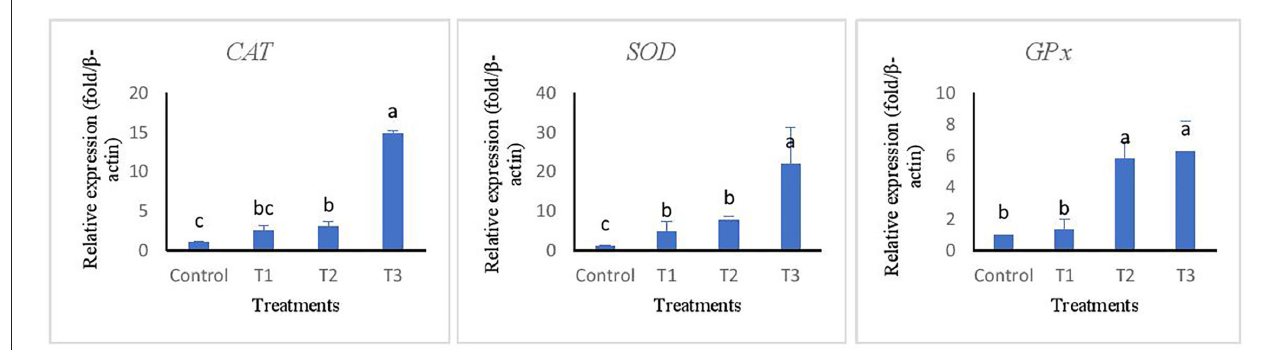
FIGURE 3 | Relative expression of antioxidant related genes of superoxide dismutase (SOD), catalase (CAT), and glutathione reductase (GPx) in liver tissue of rainbow trout fed diets incorporated with different levels of zero (Control), 0.5% (T1), 1% (T2) and 2% (T3) of a mixture of herbs ( Mentha longifolia , Thymus carmanicus , Trachyspermum copticum ) for 45 days. Data represent mean ± SE. Bars with different letters indicate significant